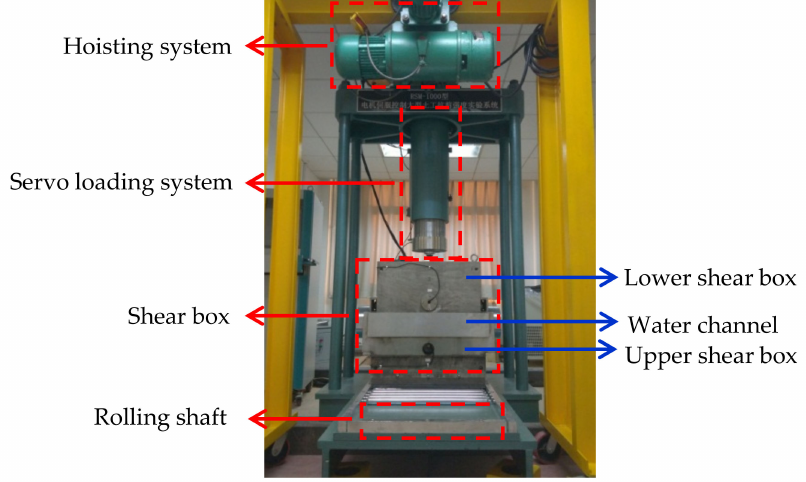
Figure 4. SRM-1000 large-sized geotechnical shear strength test apparatus controlled by a motor